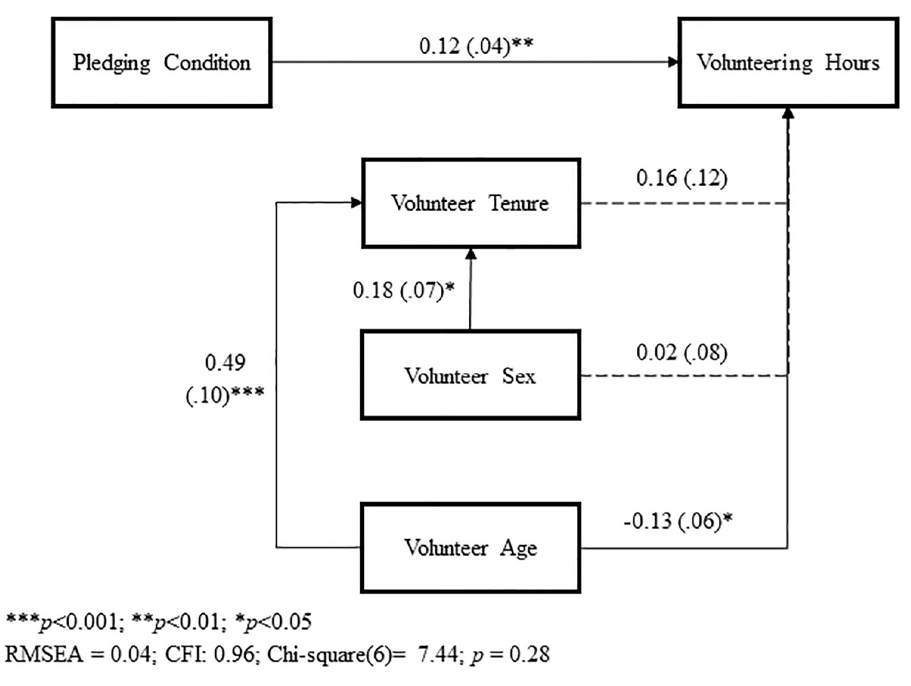
Fig 2. Path model analysis, Study